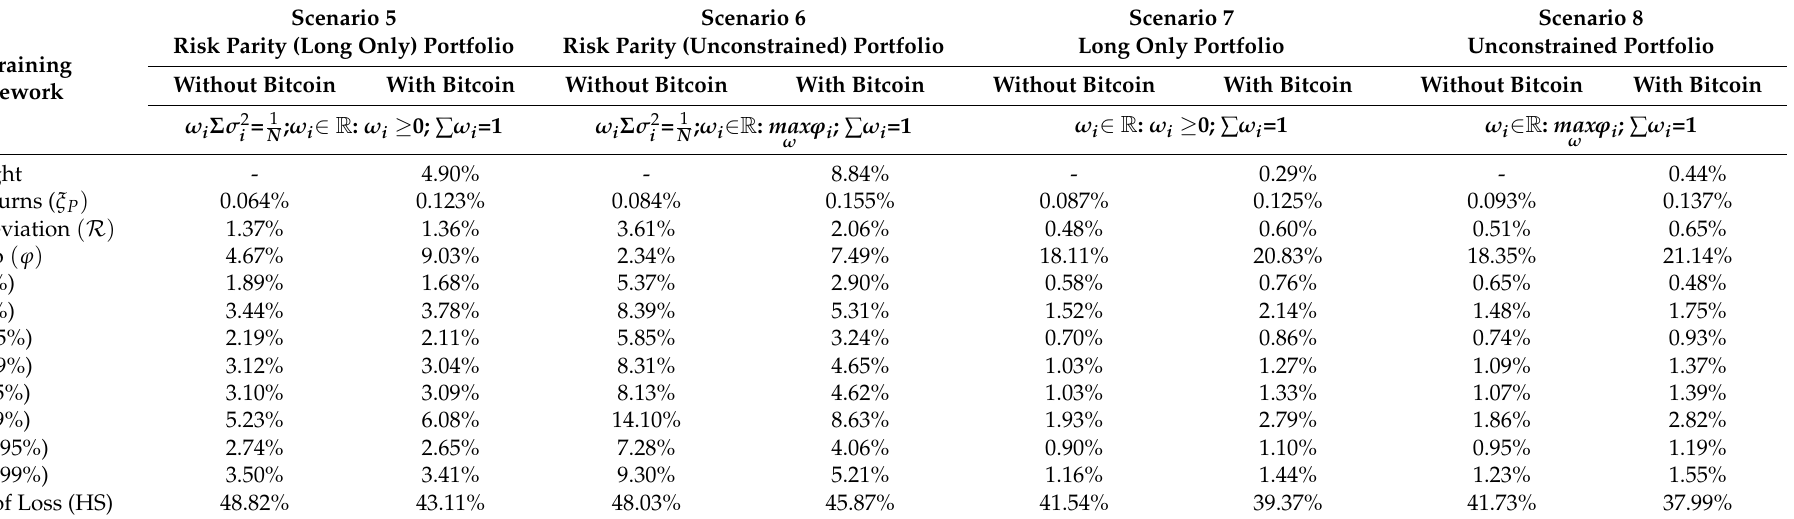
Table 6. Portfolio Optimization (Scenarios 5 to 8).